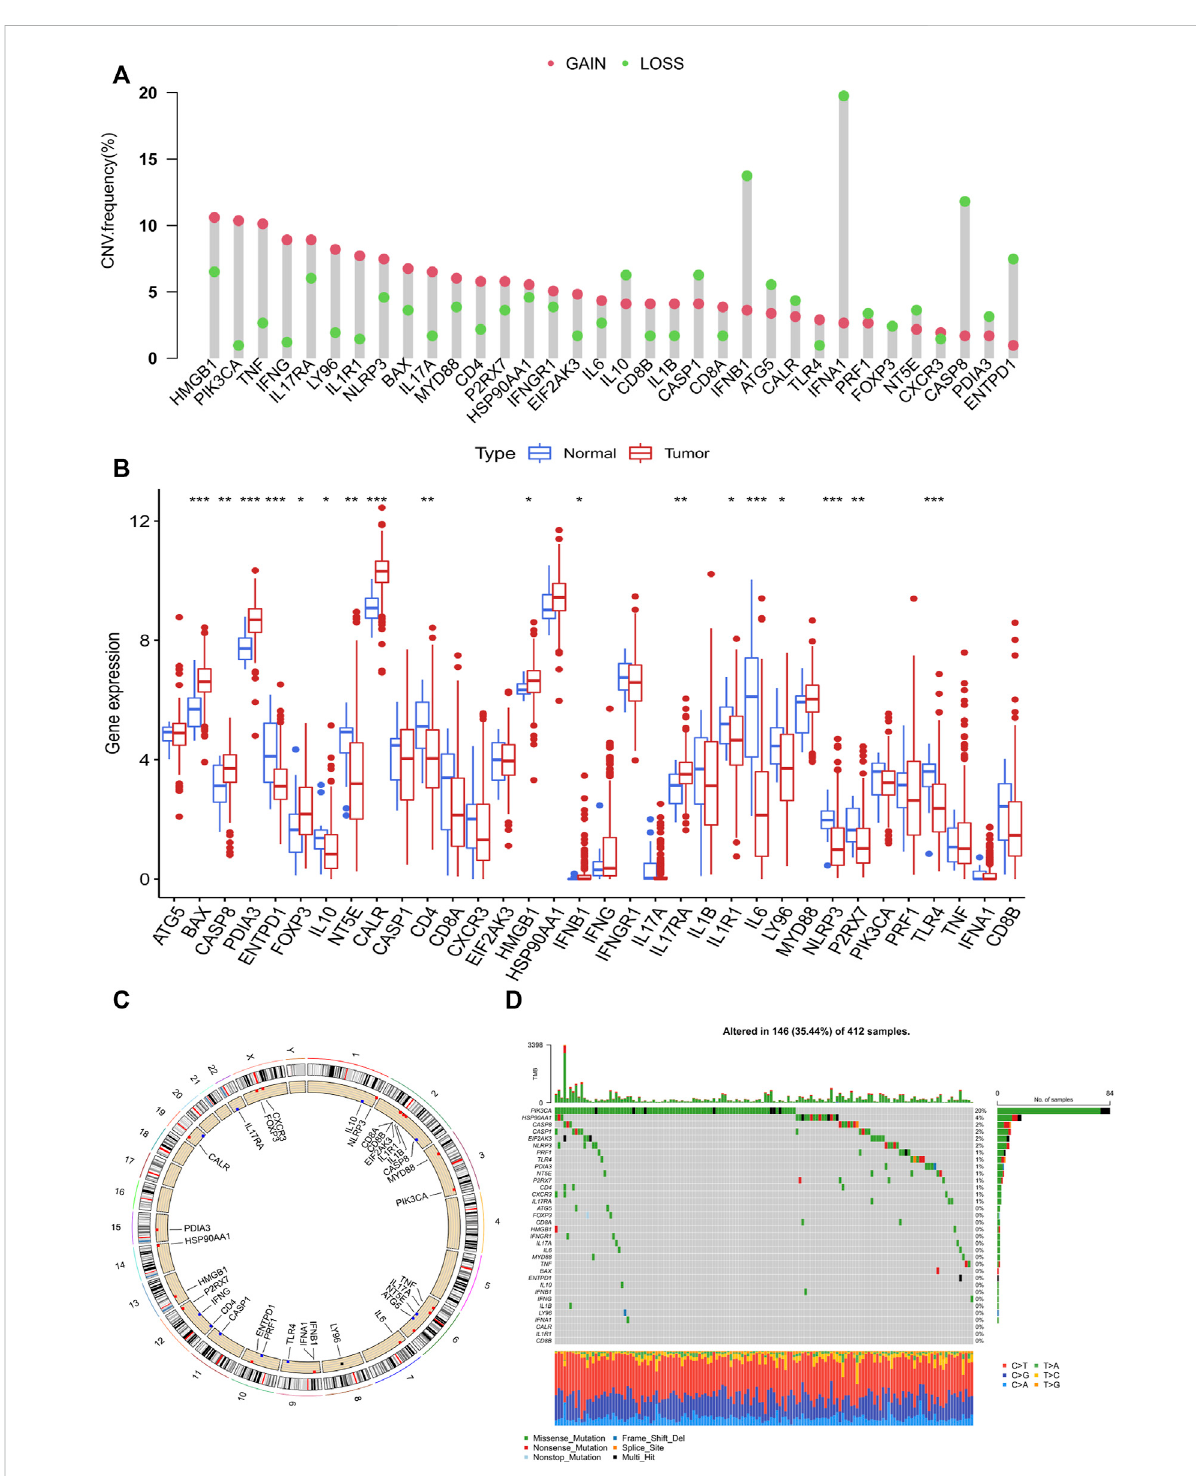
FIGURE 1 Landscape of genetic variations in IRGs in bladder cancer. (A) CNV distributions of IRGs in bladder cancer. (B) Different expressions of IRGs in tumour and normal tissues. (C) CNV locations of IRGs on 23 human chromosomes. (D) Waterfall plot demonstrating the somatic mutation status of IRGs in bladder cancer. Each column represents a single sample and the upper bar graph represents the TMB value. The number on the right represents the frequency of somatic